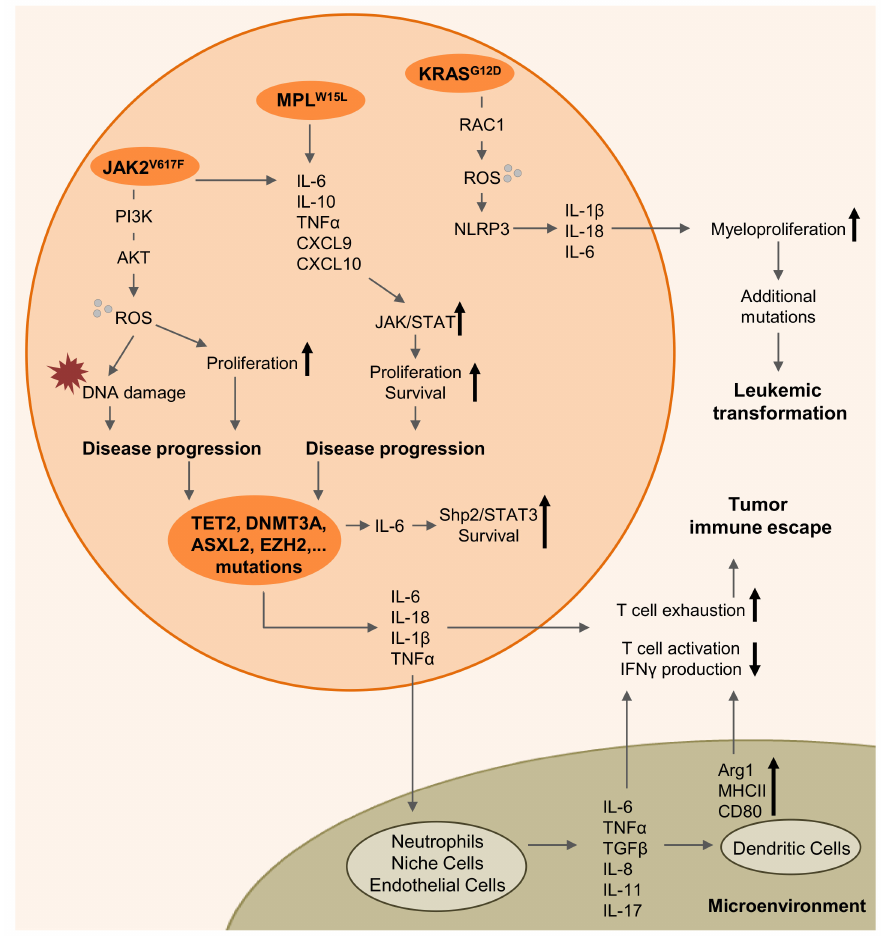
Figure 1. Pro-inflammatory signaling processes driving myeloproliferation and leukemia immune escape in myeloid malignancies. Oncogenic mutations stimulate increased production of ROS and pro-inflammatory cytokines and interleukins. ROS causes DNA damage and favors proliferation of the mutant clone, thereby driving disease progression. Cytokines drive disease progression through elevated Shp2 / STAT3 and JAK / STAT signaling. NLRP3-Inflammsome activation results in enhanced myeloproliferation, driving leukemic transformation of myeloproliferative diseases. Increased cytokine signaling in the tumor microenvironment contributes to T-cell exhaustion, reduced T-cell activation, and leukemia immune